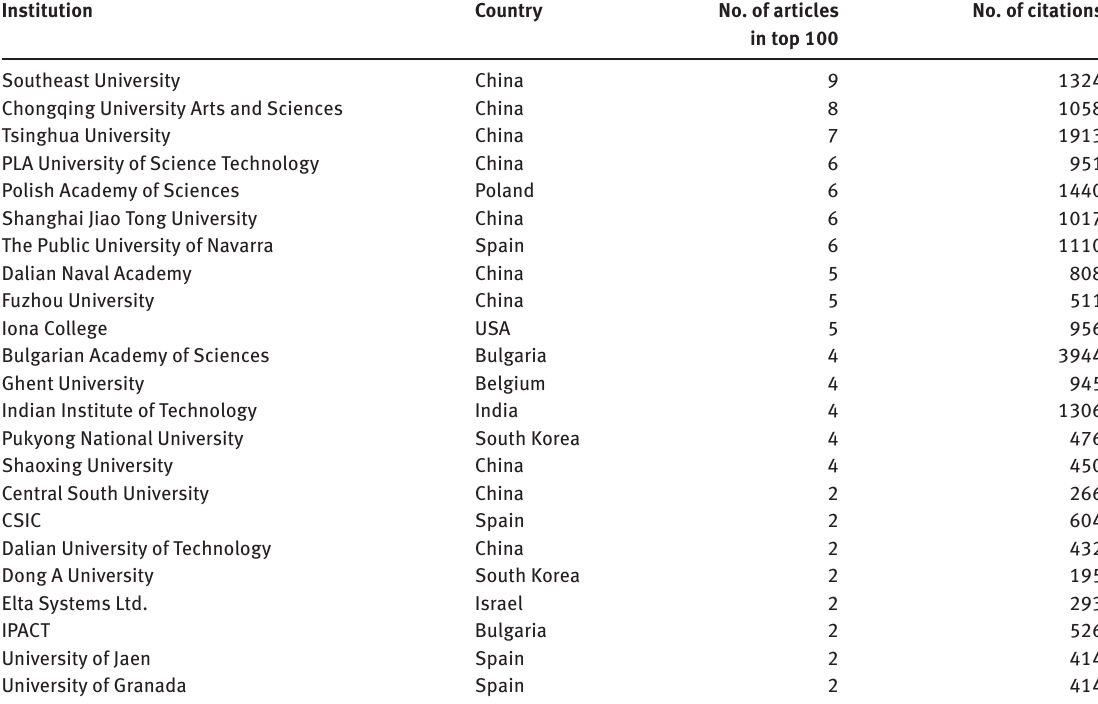
Table 4: Institutions with the Top 100 Cited IFS Articles (n ≥